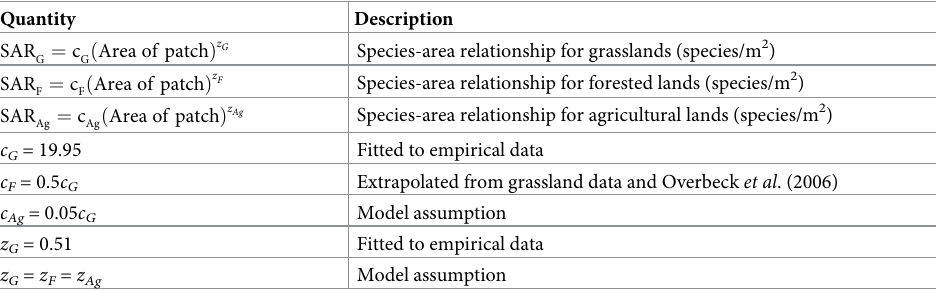
Table 1. Parameter